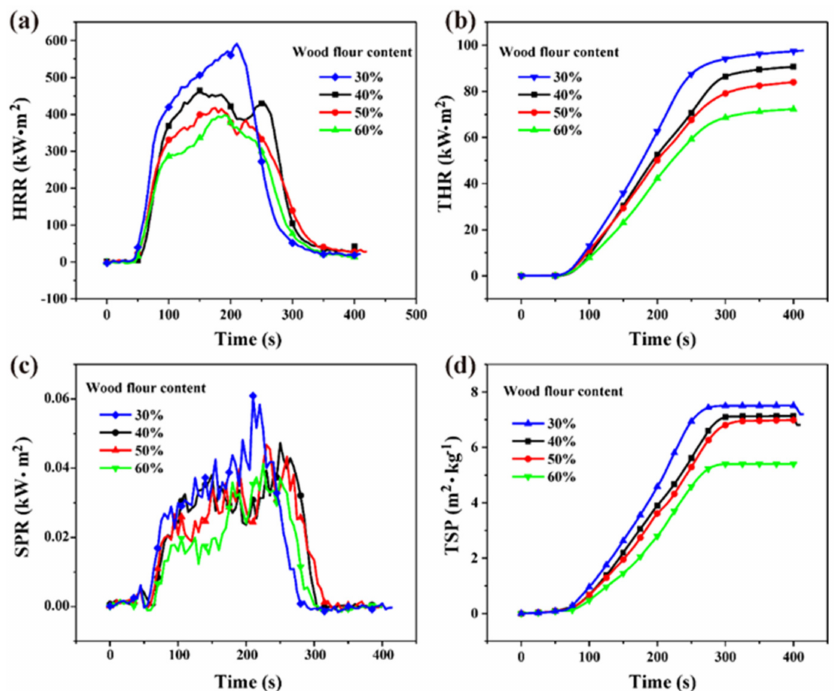
Figure 4. Combustion parameters of the borated wood flour/HDPE composites. ( a ) heat release rate (HRR), ( b ) total heat release THR, ( c ) smoke production rate (SPR), and ( d ) total smoke produc- tion